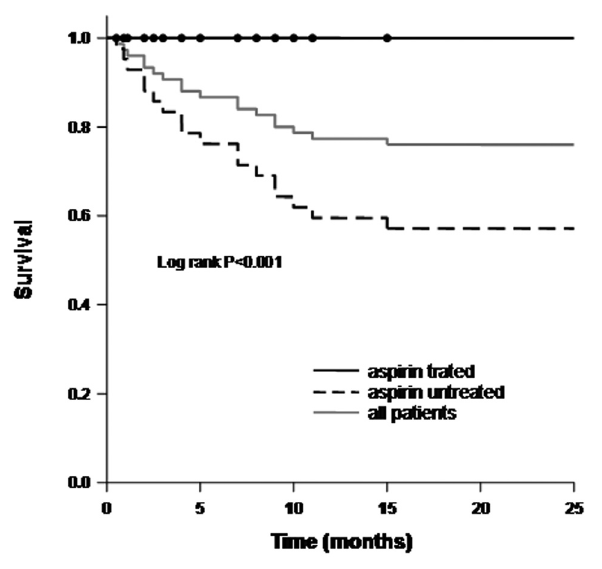
Figure 1 - Kaplan-Meier survival curves for participants under aspirin treat- ment (solid line) versus subjects without aspirin (dashed line). Survival curve in the 24-month follow-up for all 75 patients with severe peripheral arterial disease is displayed by gray